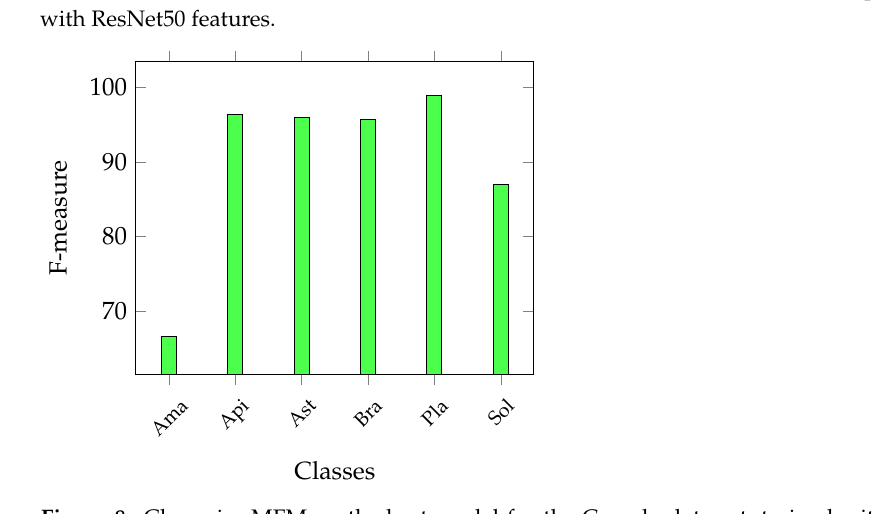
Figure 8. Classwise MFM on the best model for the Canada data set, trained with HC features: Ensemble with Texture